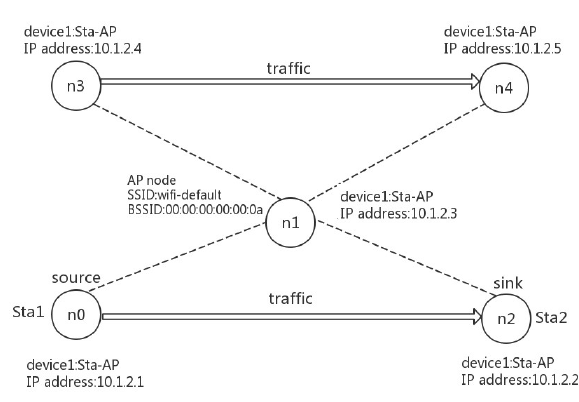
Figure 3. 5 nodes topology.